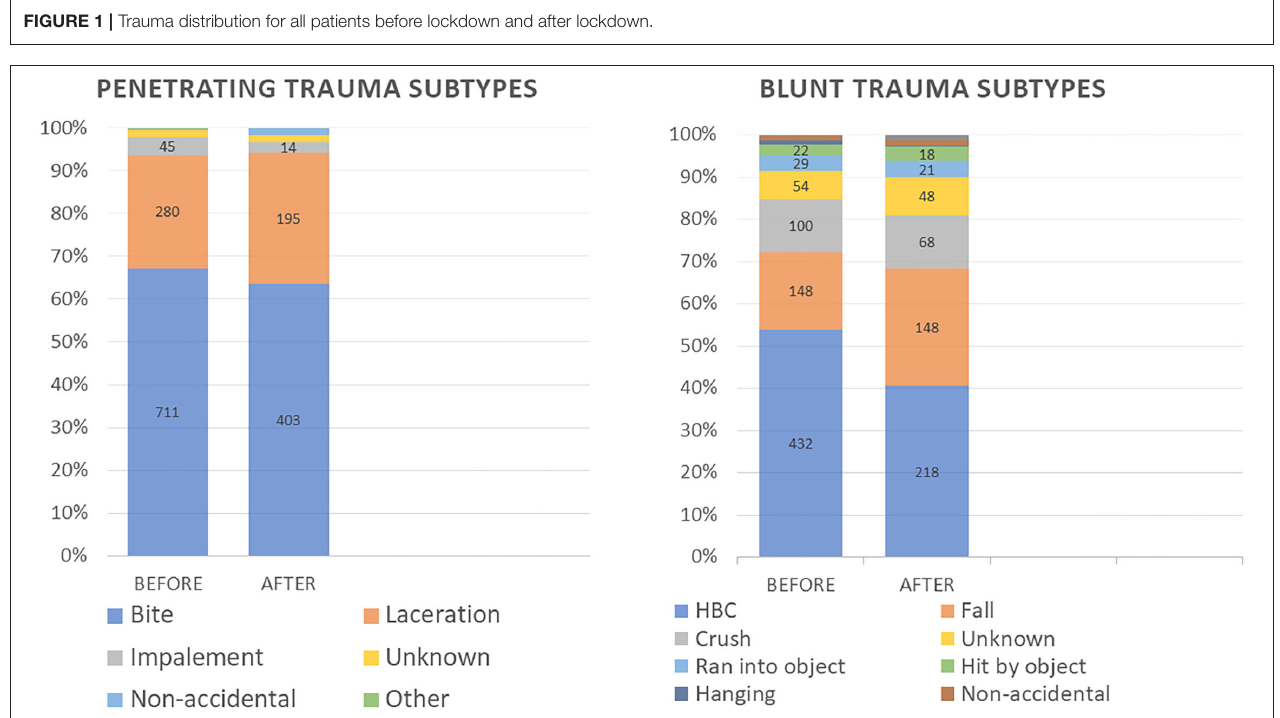
FIGURE 2 | Penetrating and Blunt Trauma subtype distribution for all patients before lockdown and after